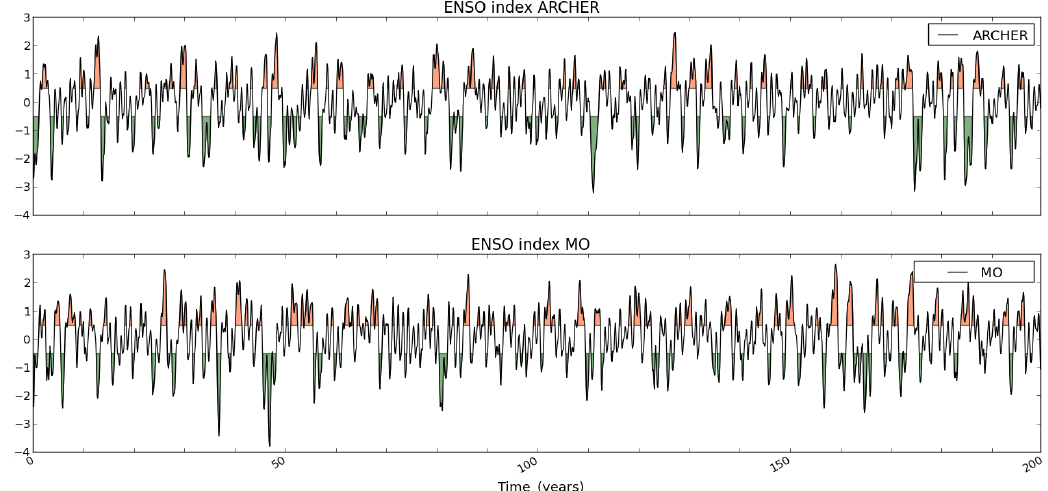
Figure 12. The Niño 3.4 index for PI MO and PI AR . A 3-month running mean was applied to the ENSO signal, and values greater and smaller than or equal to ± 0 . 5 are shaded in orange and